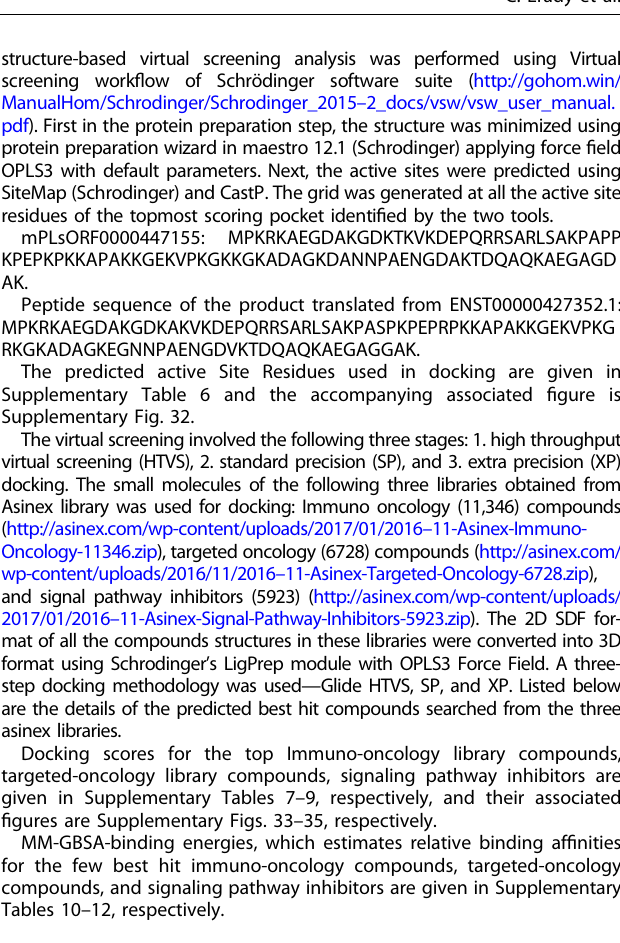
Supplementary Fig. 32. The virtual screening involved the following three stages: 1. high throughput virtual screening (HTVS), 2. standard precision (SP), and 3. extra precision (XP) docking. The small molecules of the following three libraries obtained from Asinex library was used for docking: Immuno oncology (11,346) compounds (http://asinex.com/wp-content/uploads/2017/01/2016 – 11-Asinex-Immuno- Oncology-11346.zip), targeted oncology (6728) compounds (http://asinex.com/ wp-content/uploads/2016/11/2016 – 11-Asinex-Targeted-Oncology-6728.zip), and signal pathway inhibitors (5923) (http://asinex.com/wp-content/uploads/ 2017/01/2016 – 11-Asinex-Signal-Pathway-Inhibitors-5923.zip). The 2D SDF for- mat of all the compounds structures in these libraries were converted into 3D format using Schrodinger ’ s LigPrep module with OPLS3 Force Field. A three- step docking methodology was used — Glide HTVS, SP, and XP. Listed below are the details of the predicted best hit compounds searched from the three asinex libraries. Docking scores for the top Immuno-oncology library compounds, targeted-oncology library compounds, signaling pathway inhibitors are given in Supplementary Tables 7 – 9, respectively, and their associated fi gures are Supplementary Figs. 33 – 35, respectively. MM-GBSA-binding energies, which estimates relative binding af fi nities for the few best hit immuno-oncology compounds, targeted-oncology compounds, and signaling pathway inhibitors are given in Supplementary Tables 10 – 12,